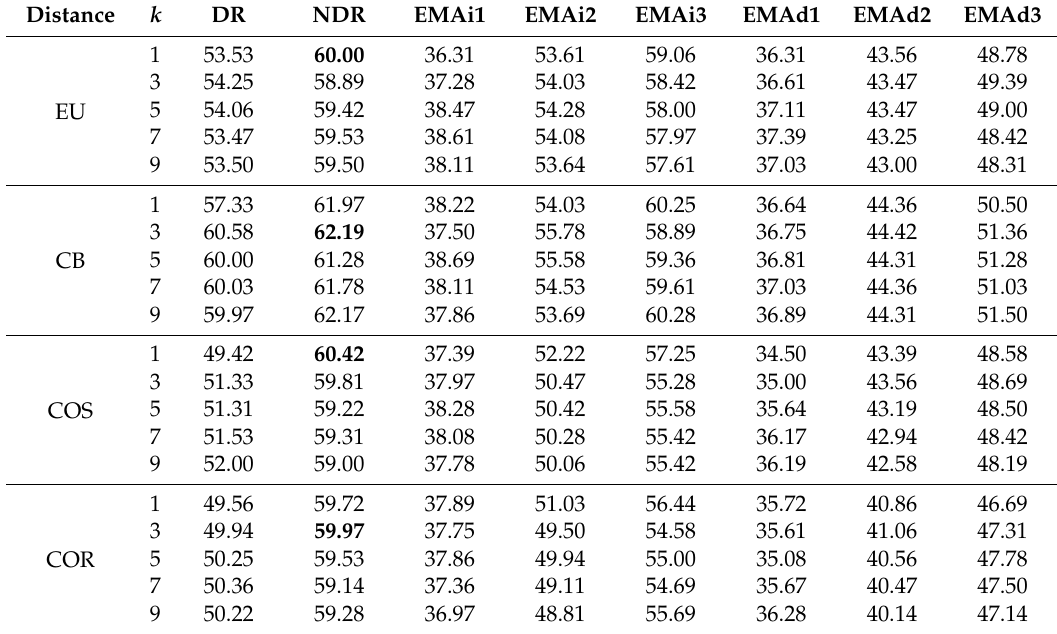
Table 6. Classification results of eight features based on different values of k and distance metrics for Dataset II (%).